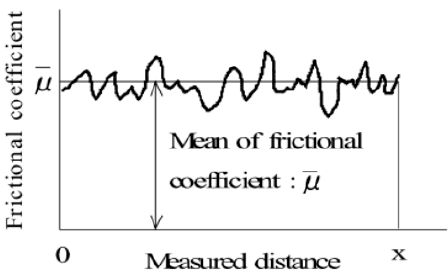
Figure 14. Principle of surface property measurement.